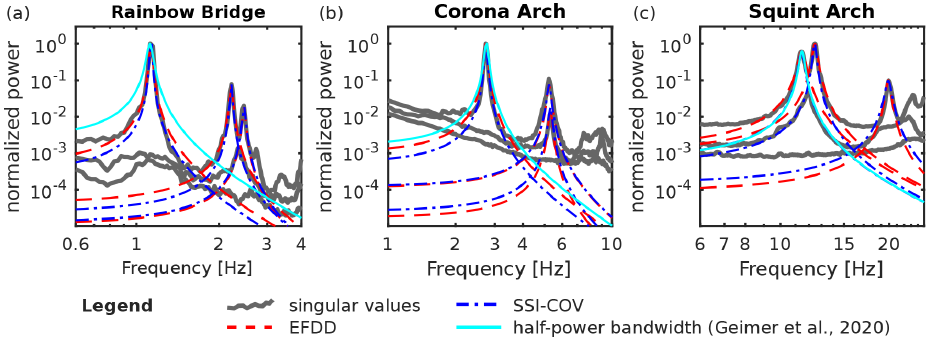
Figure 7. Singular value plots with spectra of single-degree-of-freedom systems modeled by using input data from EFDD (red), SSI-COV (blue), and the half-power bandwidth technique (cyan). At Rainbow Bridge (a) and Corona Arch (b) , damping estimated by the half-power bandwidth technique is overestimated and does not match the mode bells, while the fit is good at Squint Arch (c)